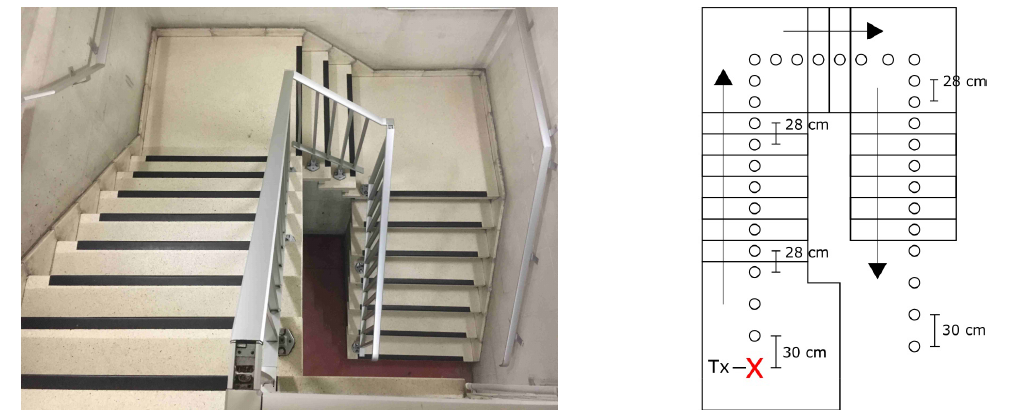
Figure 6. Scenario ST1: Photo of Staircase 1 ( left ); and graphical representation of the measurement points ( right ).